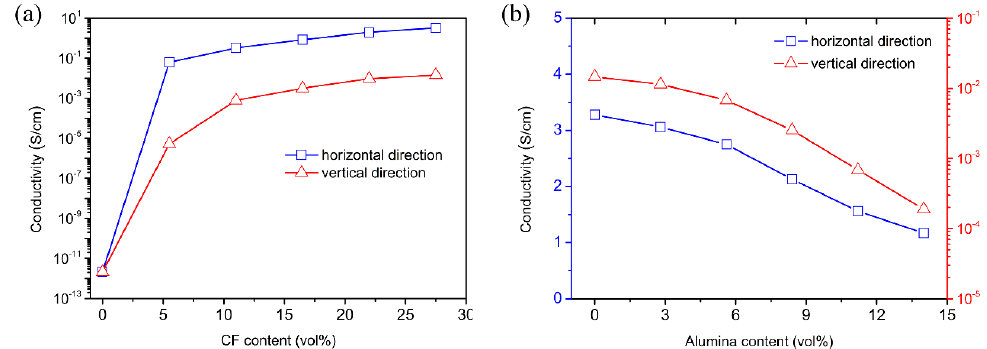
Figure 8. ( a ) The dependence of the electrical conductivities of the PDMS/CF composites in the horizontal and vertical directions on the CF content when the alumina content was 0, ( b ) the dependence of the electrical conductivities of the PDMS/alumina/CF composites in the horizontal and vertical directions on the alumina content when the CF content was 27.5 vol%.